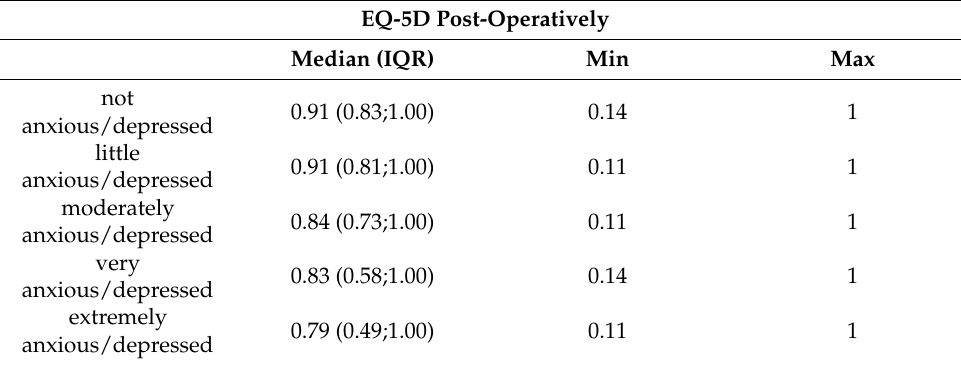
Table 2. The impact of preoperative anxiety/depression on EQ-5D values postoperatively: Median (IQR), minimum and maximum values.